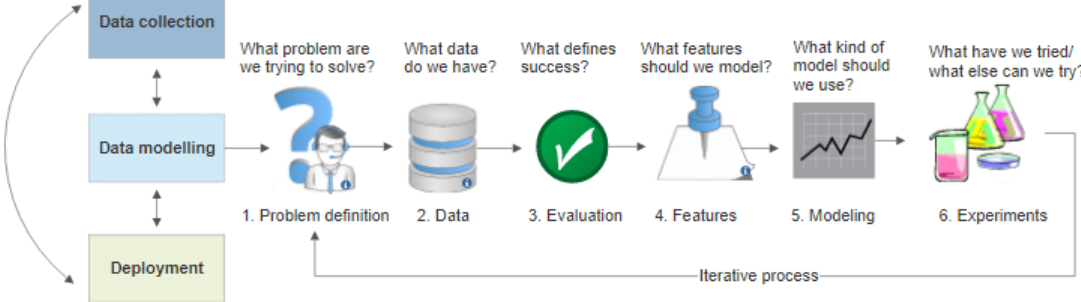
Figure 4. Machine learning